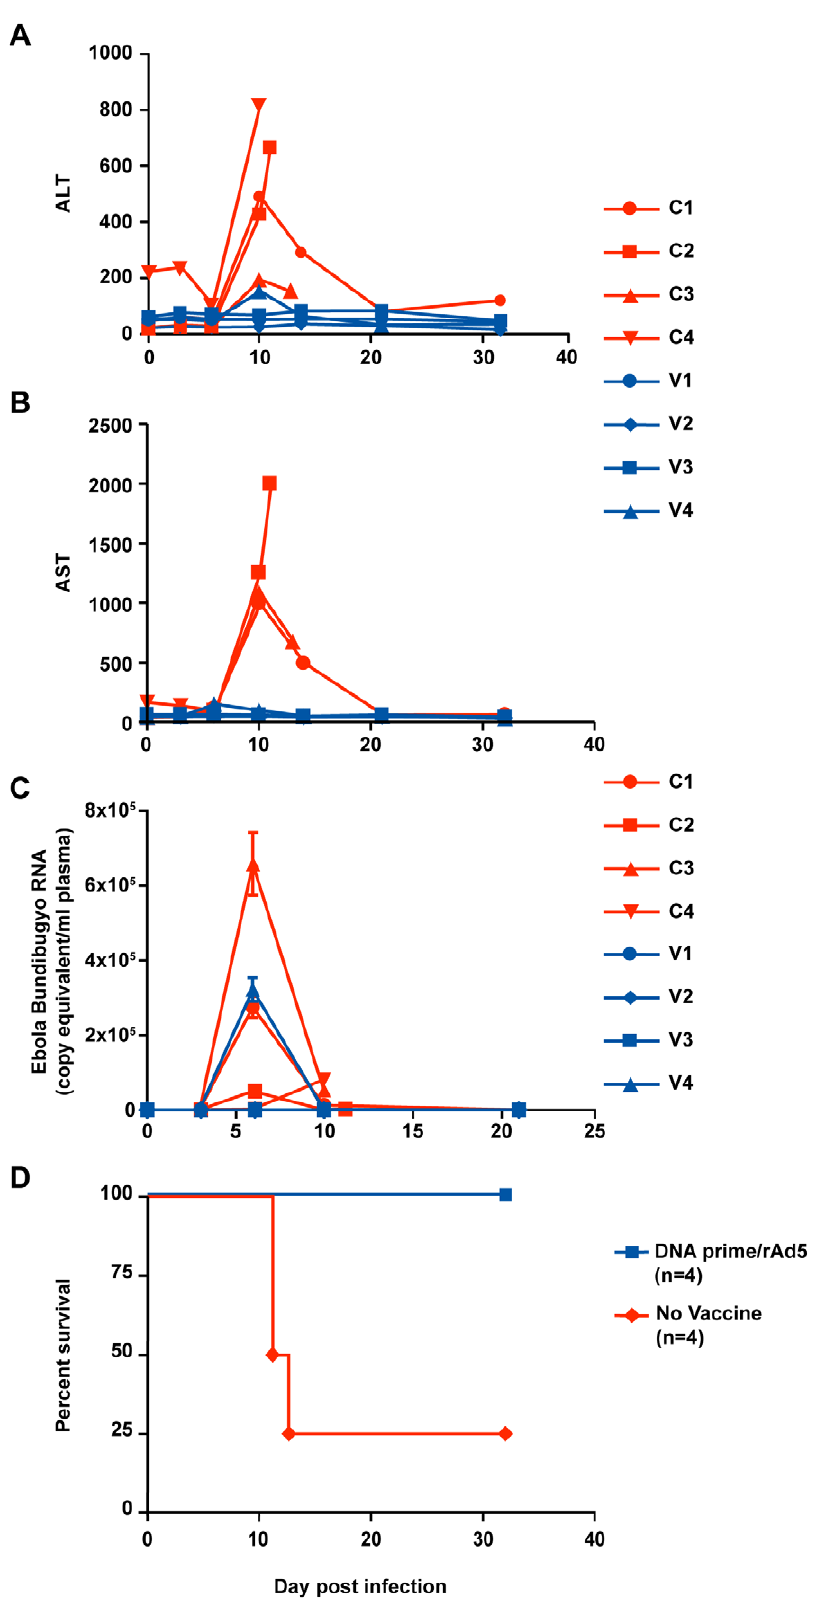
Figure 4. Bundibugyo EBOV challenge. Control and vaccinated animals were exposed to a target dose of , 1,000 TCID 50 of BEBOV. Blood samples were collected before and after infection for the determination of hepatic enzyme levels. ALT (panel A) and AST (panel B) were measured using a General chemistry 12 reagent disk for the Piccolo Analyzer (Abaxis). Viral load (panel C) was determined by quantitative RT-PCR of plasma